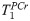
Numeric simulation of percentage error in kf calculations due to physiological variations in spin parameters.(A) error due to variation in the PCr/ATP ratio (B) error due to changes in T1PCr (C) error due to variations in T1ATP (D) error due to variations in both PCr/ATP ratio and T1PCr, kf was fixed at 0.3 (s-1) for this simulation. Parameters used for these numeric simulations were the same as given in Fig 2.